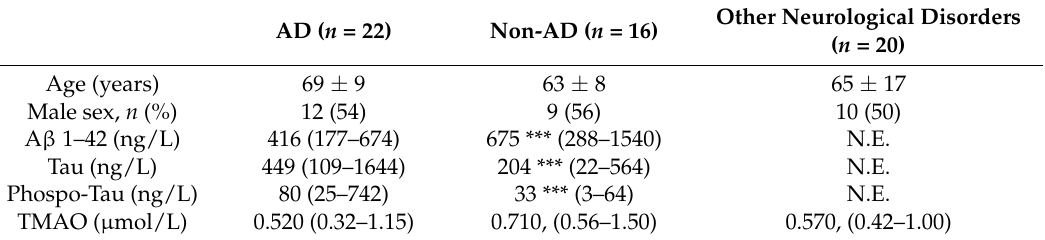
Table 1. Demographic data and dementia diagnostic